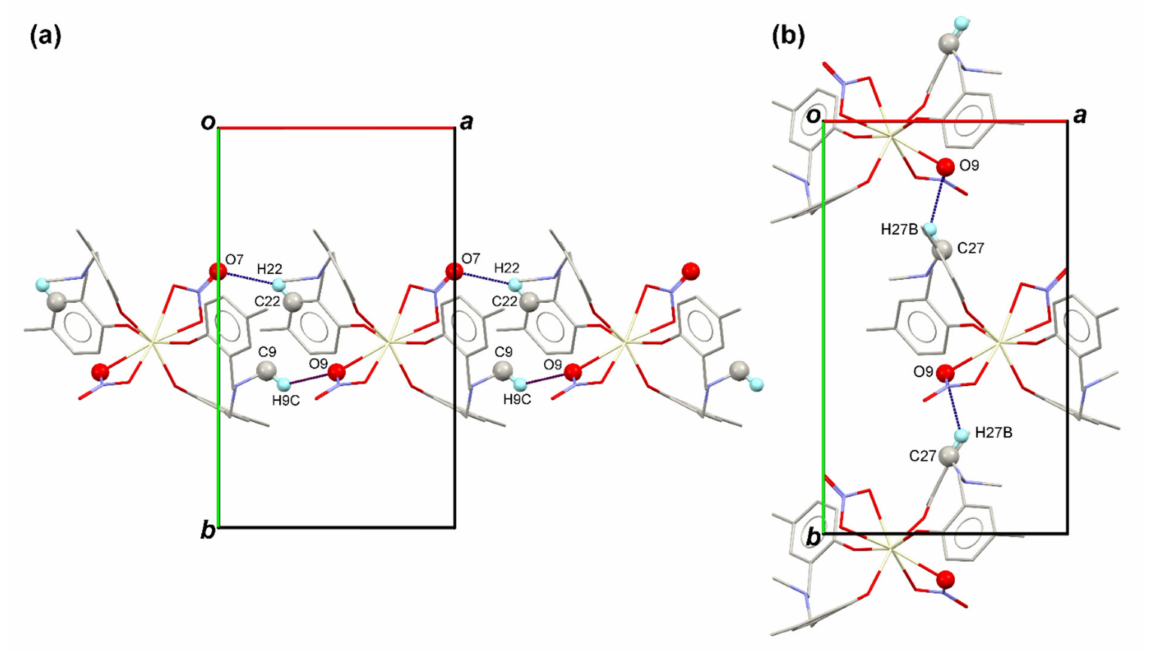
Figure 3. A [001] direction view showing ( a ) the part of molecular chain joined by the C9–H9C · · · O9 and C22–H22 · · · O7 interactions propagating along the [100] direction and ( b ) the part of the molecular chain linked via the C27–H27B · · · O9 interactions propagating along the [010]